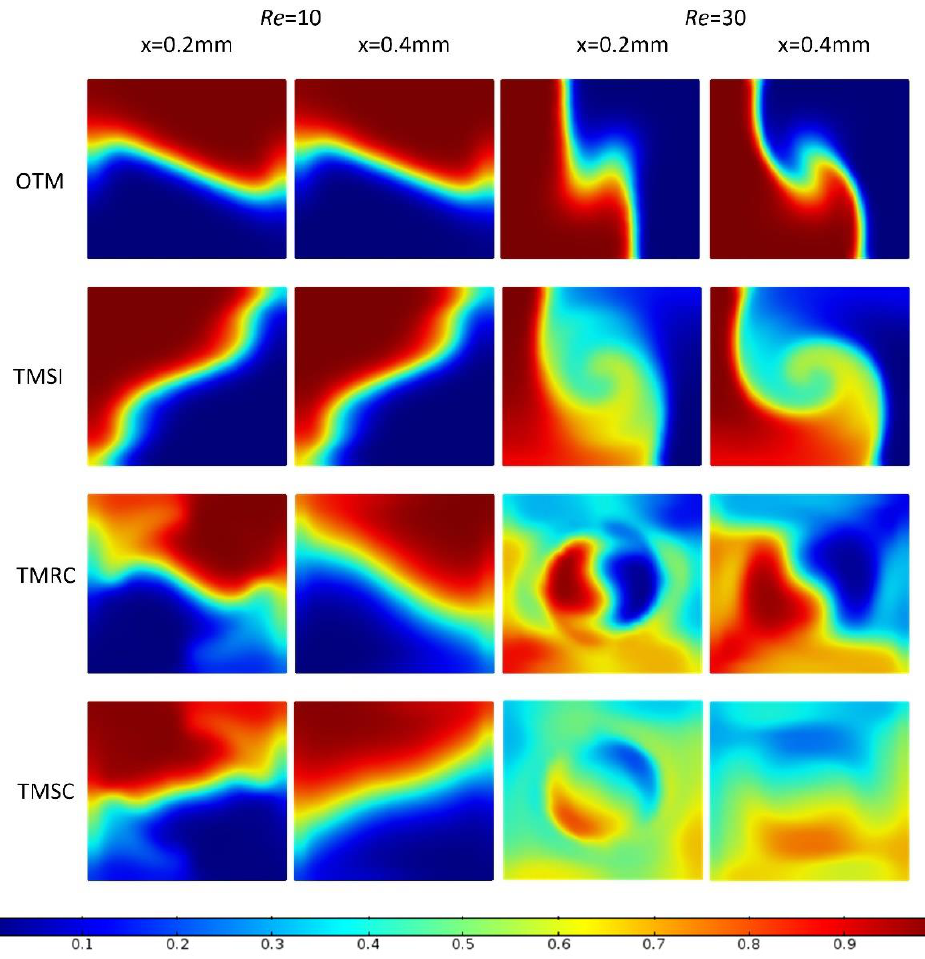
Figure 8. Concentration at each section at x = 0.2 mm and x = 0.4 mm for Re = 10 and 30.